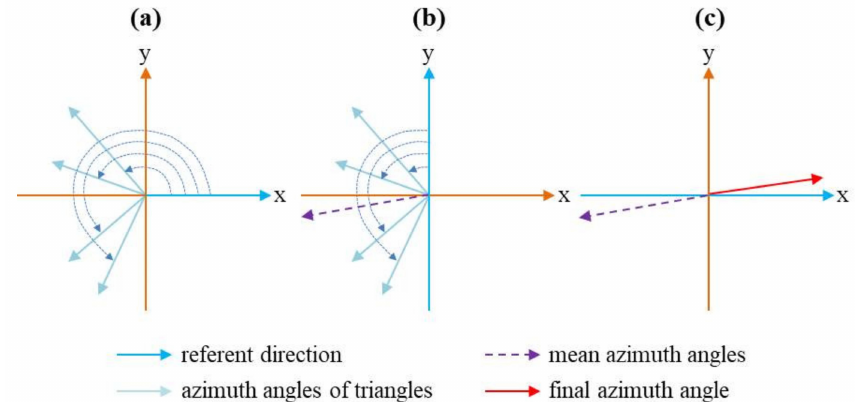
Figure 4. Examples of calculating the azimuth angles of adjacent buildings are shown for ( a ) the azimuth angles of all triangles; ( b ) the mean azimuth angle of two adjacent buildings; ( c ) the final azimuth angle of two adjacent buildings.